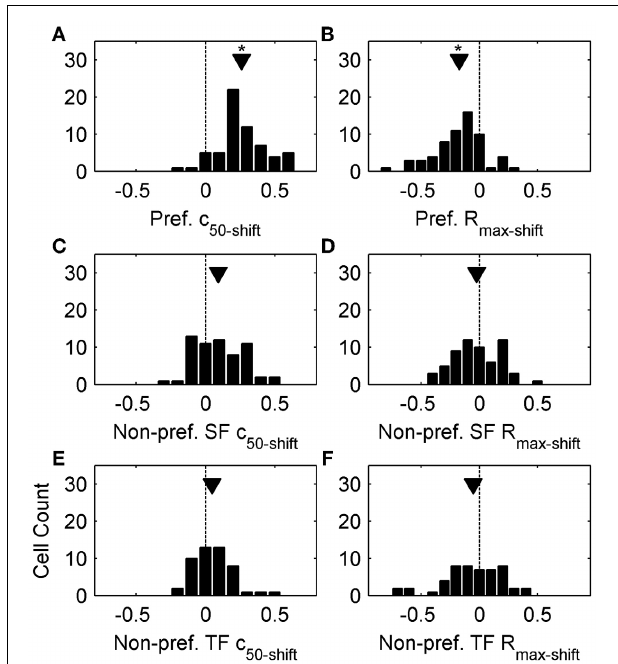
FIGURE 2 | Population data from top-up adaptation. (A,C,E) plot c 50 - shift population histograms following preferred adaptation, adaptation with non-preferred SFs, and adaptation with non-preferred TFs, respectively. (B,D,F) plot R max - shift population histograms following preferred adaptation, adaptation with non-preferred SFs, and non-preferred TFs, respectively. Arrowheads represent population means, and asterisks denote significant differences (see Results).